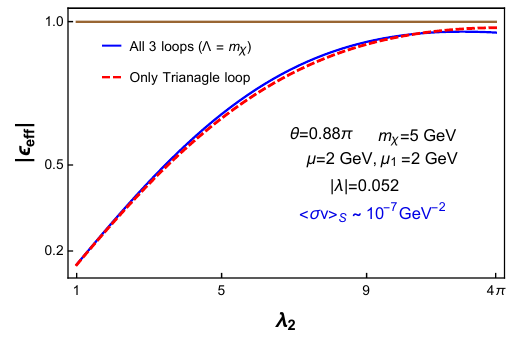
Figure 12 . The e(cid:11)ective CP-violation parameter coupling (cid:21) 2 . The results are shown for (cid:12)xed values of all other parameters, including the DM mass value of m (cid:31) = 5 GeV. The triangle loop gives the dominant contribution, as shown by comparison of (cid:15) e(cid:11) computed only with the triangle loop (red dashed line), and all the three loops (blue solid j j